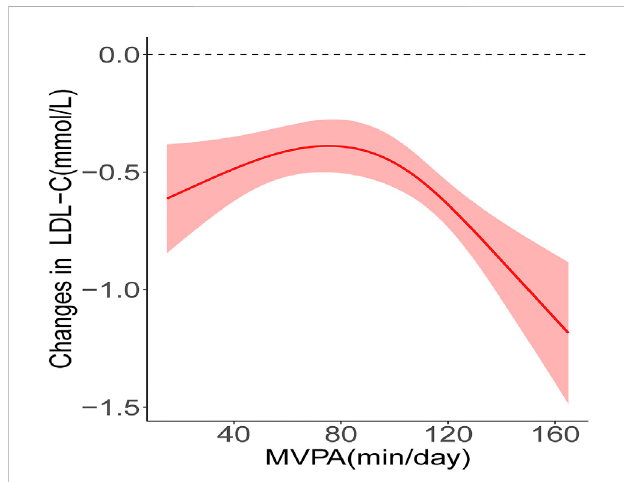
Nonlinear relationship between MVPA and LDL-C improvement. The red solid line shows the fi tted curves, thered shaded areas show the 95% con fi dence intervals.